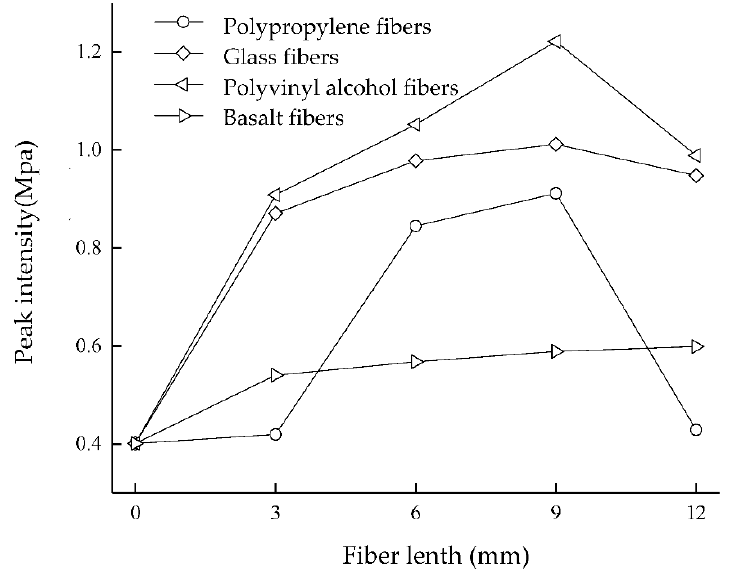
Figure 6. Unconfined compressive strength.